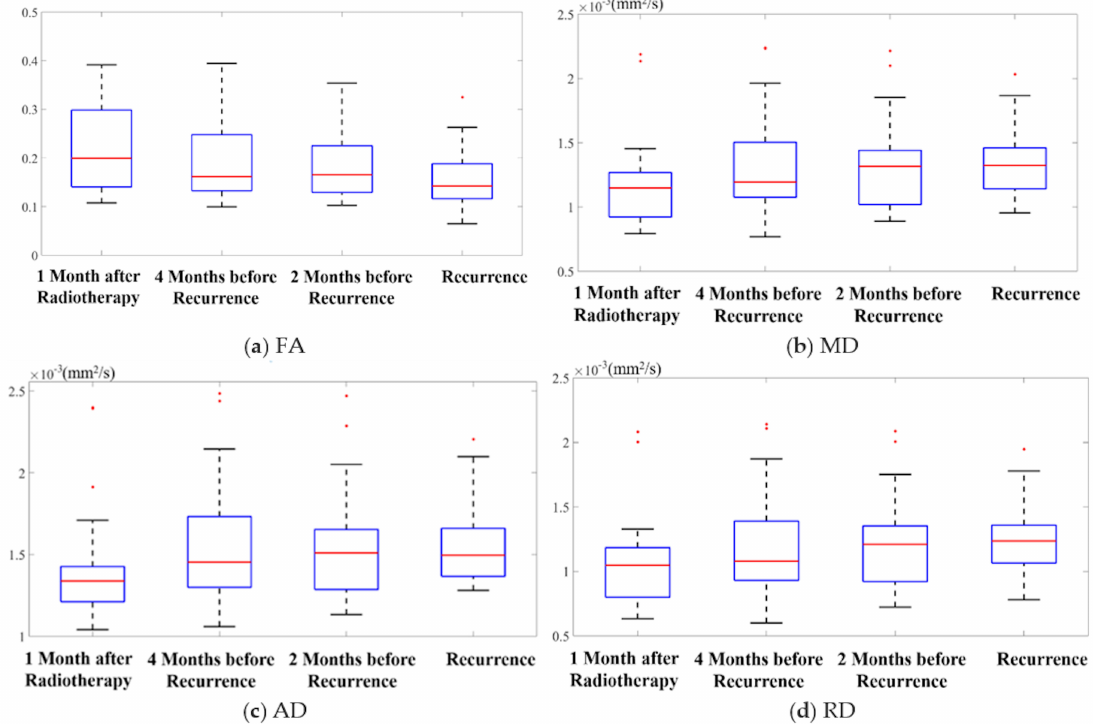
Figure 1. Box plots of the mean values of ( a ) fractional anisotropy (FA), ( b ) mean di ff usivity (MD), ( c ) axial di ff usivity (AD), and ( d ) radial di ff usivity (RD) within recurrent tumor regions over the four time points. The five bars in the box plots indicate, from bottom to top, the minimum, first quartile, median, third quartile, and the maximum. The red dots indicate